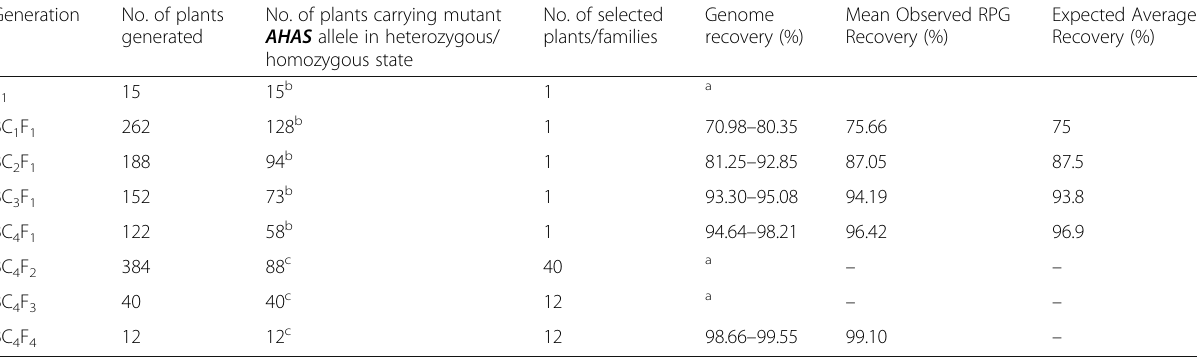
Table 4 Number of plants generated and recurrent parent genome recovery in the backcross generations during marker aided introgression of mutant AHAS allele in PB 1121